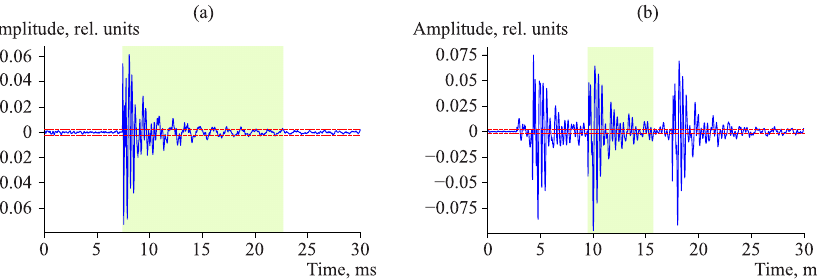
Figure 9. Examples of pulse detection from AE signal: ( a ) single pulse; ( b ) pulse of a sequence. Solid blue line shows the signal; dashed red line is the threshold. Green area shows the boundaries of the detected